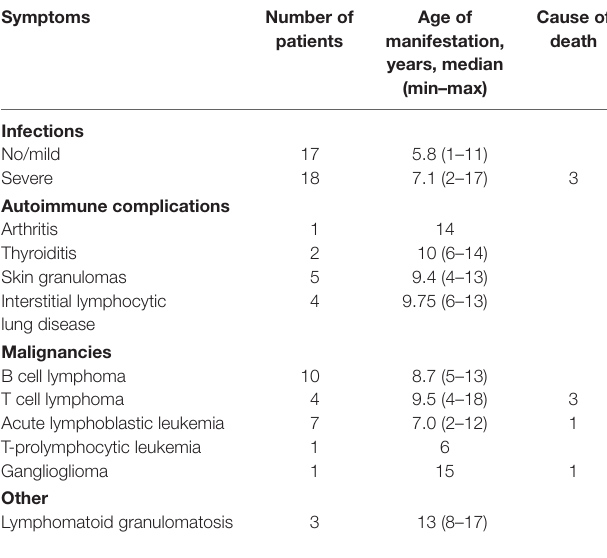
TaBle 1 | Infectious, autoimmune, and oncological complications in 35 patients with Nijmegen breakage